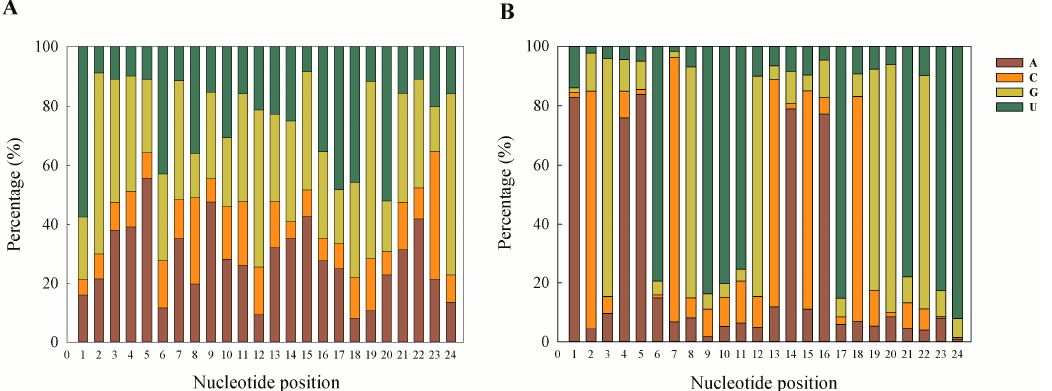
Figure 5. Nucleotide bias at each nucleotide position of known and novel miRNA of all developmental stages combined. ( A ) Known miRNA from annotation aligned to the miRNA precursor/mature miRNA in miRBase (allowing two mismatches and free gaps); ( B ) novel miRNAs predicted from the unannotated small RNAs using MIREAP software (Read ≥ 3). Table 5. Highly expressed novel miRNA across all stages of the nematode life cycle. DESeq2 Normalized Values miRNA ID Sequence (5 ′ to 3 ′ ) G + C Length Content (%)Egg J2